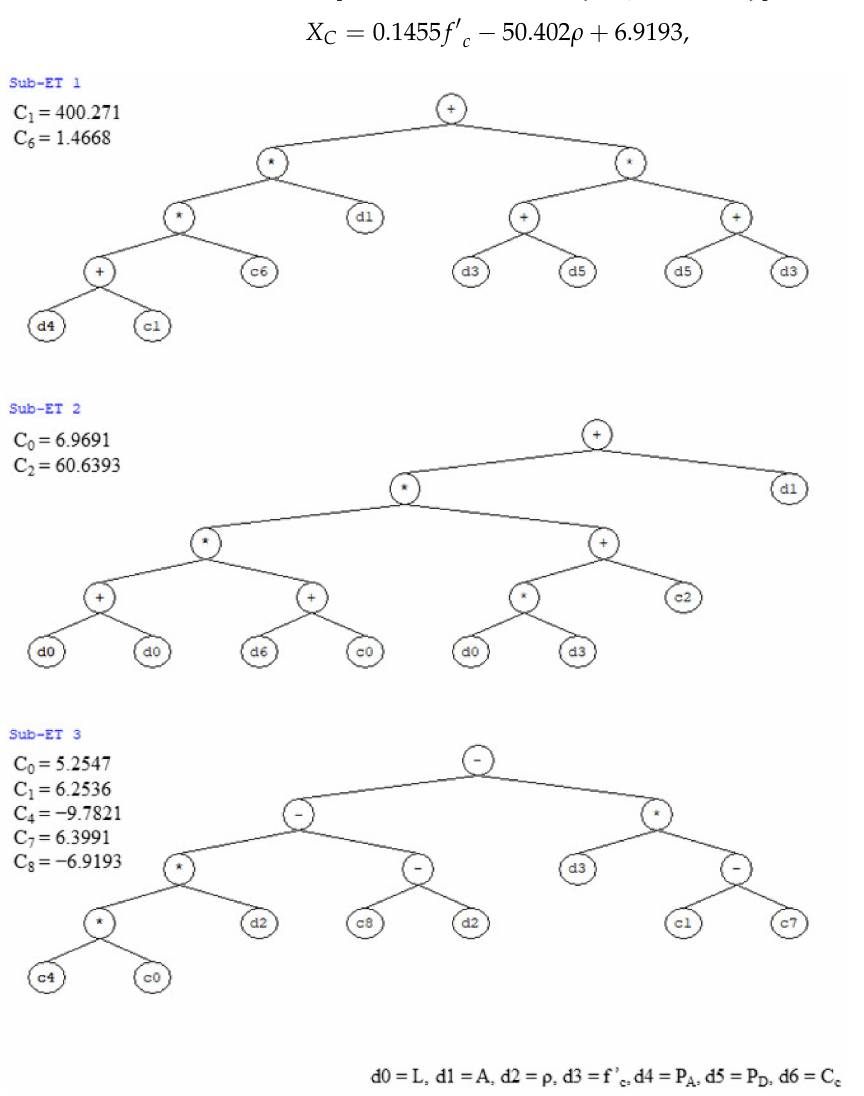
Figure 4. GEP Expression Tree for Shear Capacity